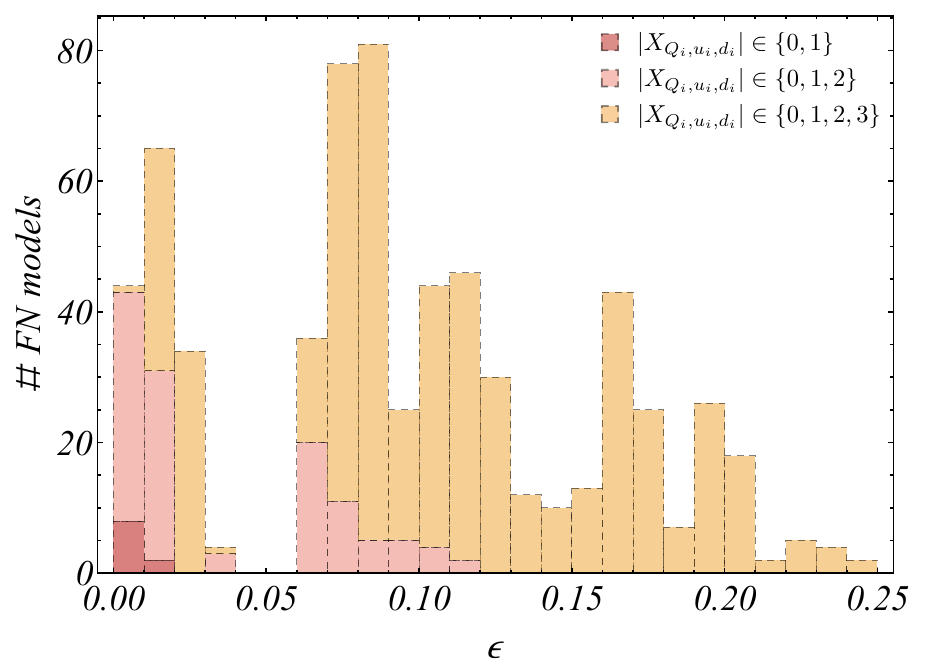
Figure 1 . Histogram of the number of viable FN models with charges in absolute value 3 as a (cid:20) function of the perturbative parameter (cid:15) = v (cid:30) = (cid:3). The models are divided into three distinct classes according to their degree of \minimality": in red FN models have charges that are only 0 or 1, in (cid:6) pink FN models have at least one charge that is equal to 2, in orange the case where at least one (cid:6) charge gets equal to 3. In our analysis, the (cid:15) parameter is inferred from data and ranges from a (cid:6) minimum value equal to 0.005 to a maximum close to 0.25. See text for more